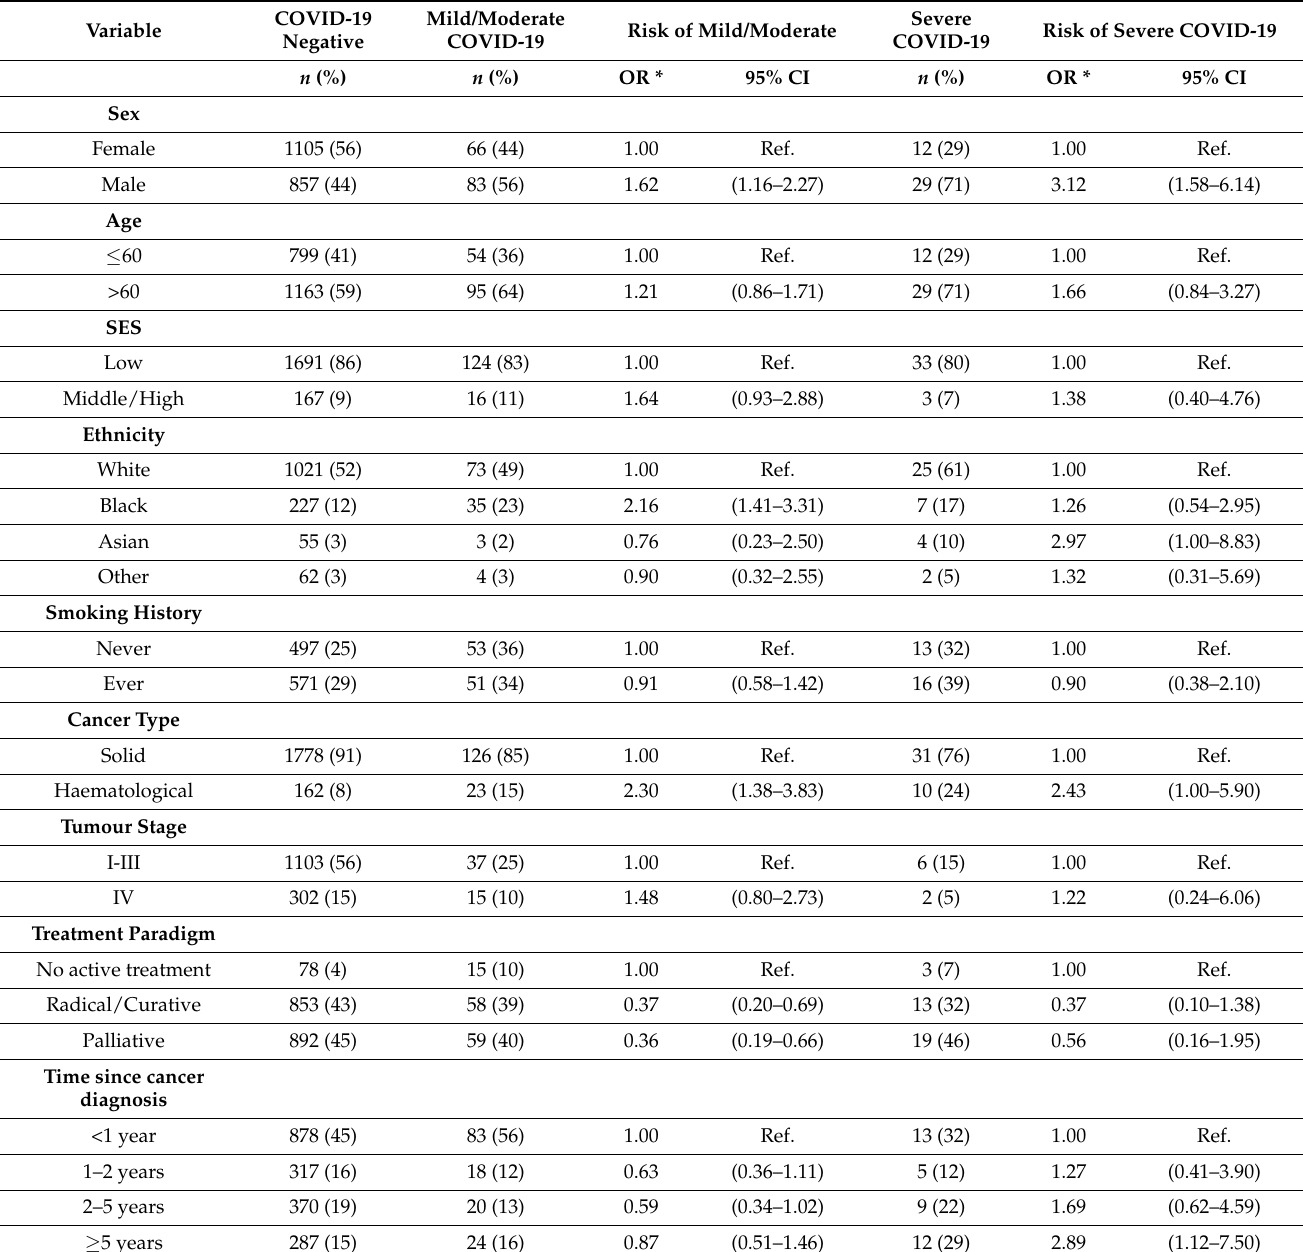
Table 3. Odds ratios and 95% confidence intervals for risk of mild/moderate and severe COVID-19 in cancer patients.